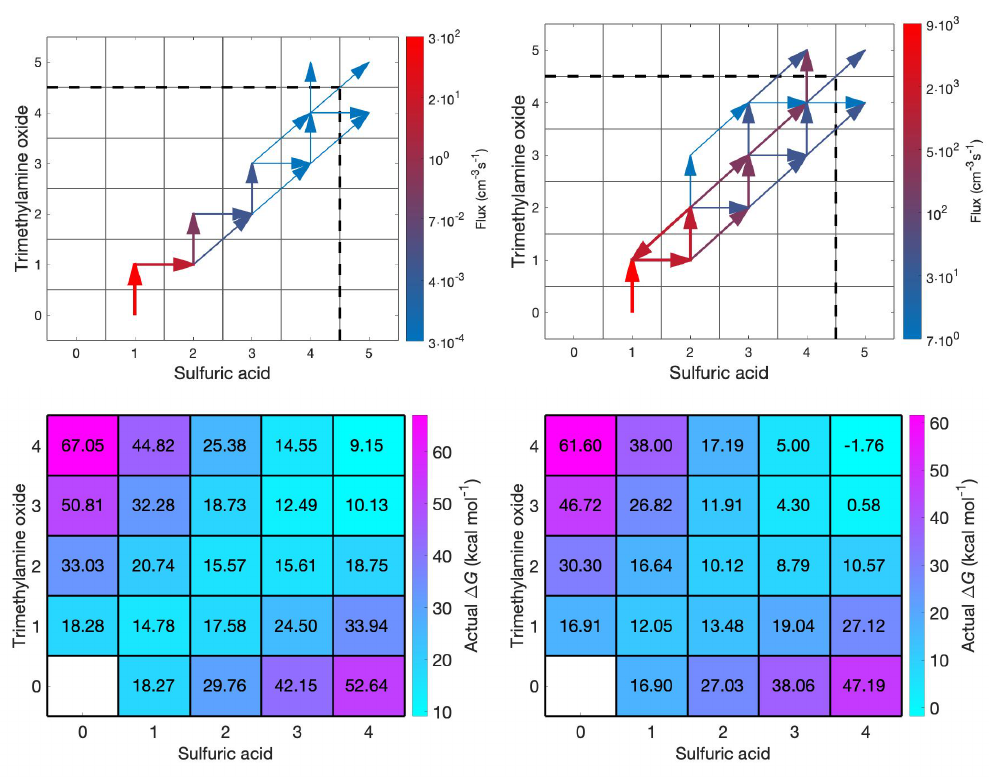
Figure 3. Main cluster growth pathways ( top ) and vapor concentration-dependent Gibbs free energies ( bottom ) for sulfuric acid (SA)–TMAO clusters at 298.15 K and vapor concentrations of [SA] = 10 6 cm − 3 and [TMAO] = 10 6 cm − 3 ( left ) and [SA] = 10 7 cm − 3 and [TMAO] = 10 7 cm − 3 ( right ). The x - and y -axes give the numbers of SA and TMAO molecules in the cluster,